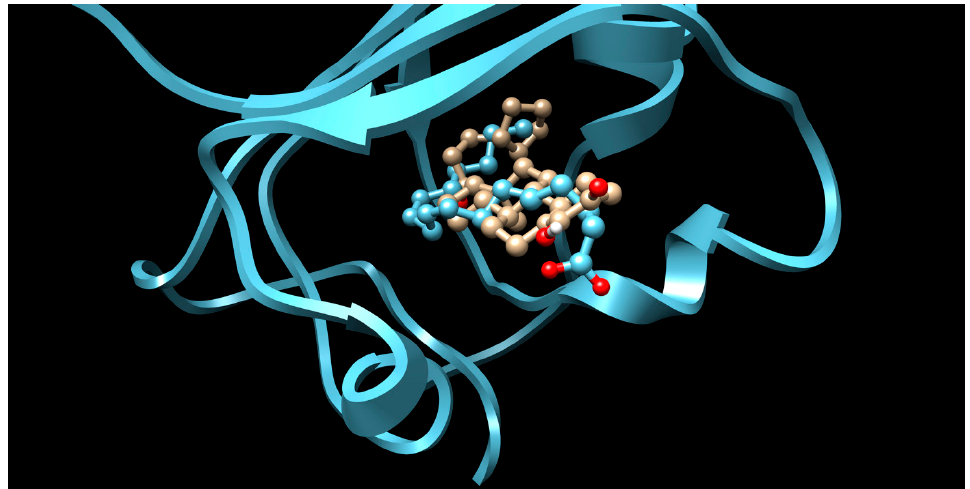
Figure 3. Superimposition of oxabalone (brown) with linoleate (cyan) in the spike FABP.